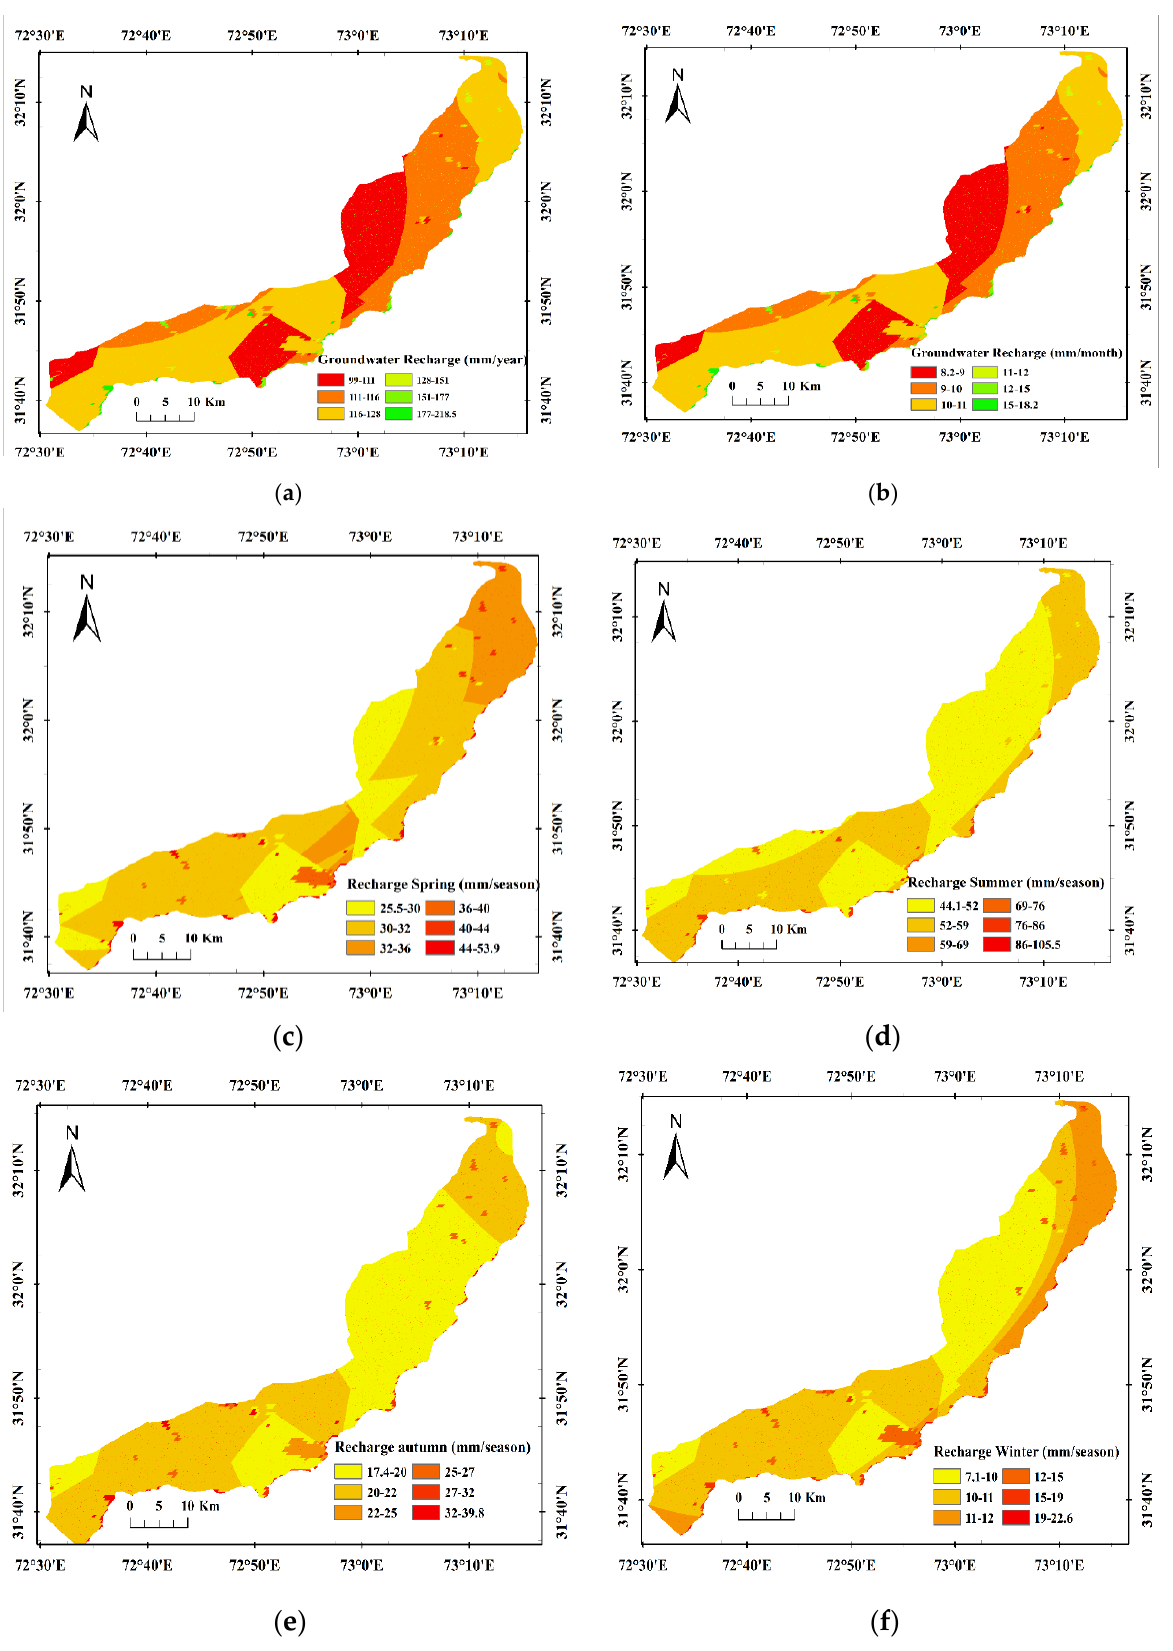
Figure 11. Long-term annual, seasonal, and monthly distribution of simulated groundwater recharge, ( a ) annual, ( b ) monthly, ( c ) spring, ( d ) summer, ( e ) autumn, and ( f ) winter.